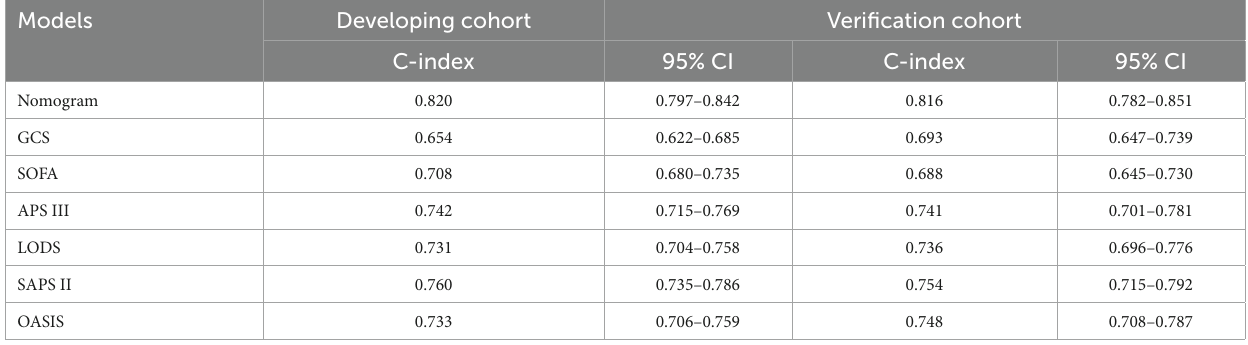
TABLE 3 C-index of nomogram and critical care scoring systems for predicting 1-year mortality in ischemic stroke patients.